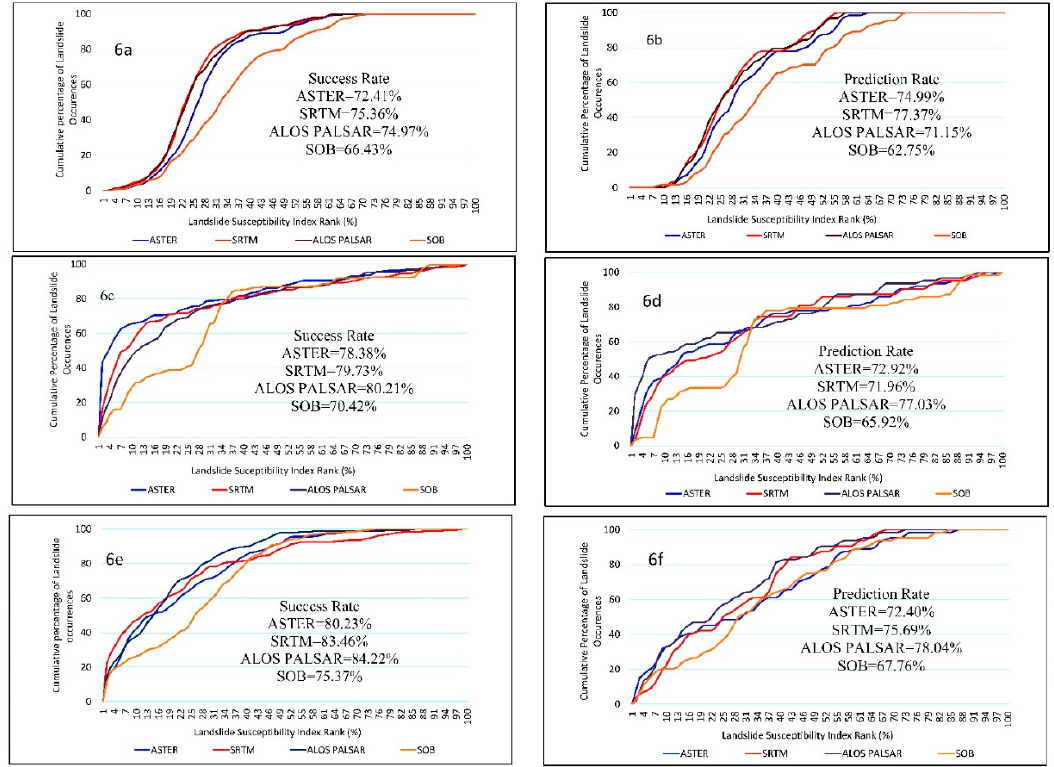
Figure 6. Success and prediction rate curves (15 factors): ( a ) MFR (success); ( b ) MFR (prediction); ( c ) LR (success); ( d ) LR (prediction); ( e ) RF (success); ( f ) RF (prediction).